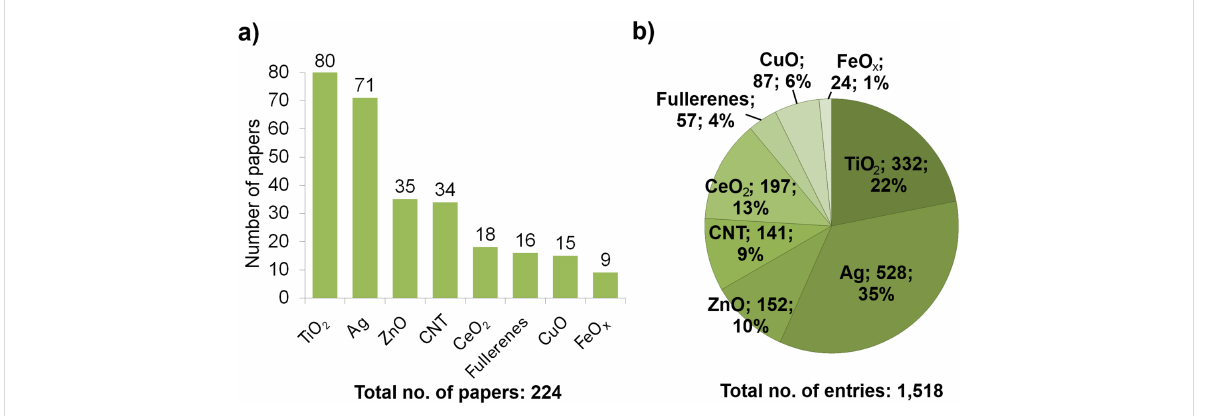
Figure 2: Information in the NanoE-Tox database for different types of engineered nanomaterials (ENMs): (a) number of scientific papers in the data- base and (b) number and share of entries for each of the tested nanoparticles (ENM; number of entries; share of entries). One entry equals one line that includes all the ENM parameters and toxicity test details. The database entries were selected based on bibliometric data search in Thomson Reuters WoS using the keywords as indicated in Table 1 as of January 6, 2015.